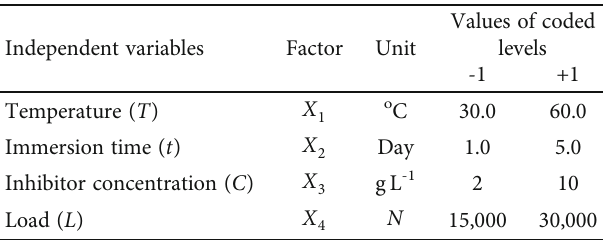
Table 2: Factors and values at two levels for batch corrosion